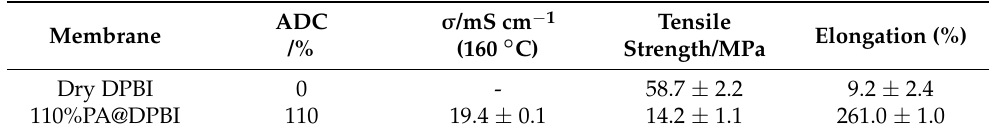
Table 1. Proton conductivities and mechanical properties of PA undoped DPBI and DPBI membranes with ADC around